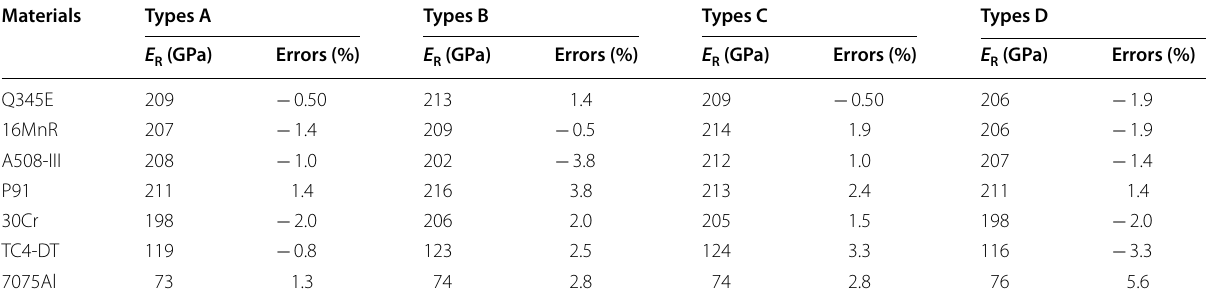
Table 5 Comparison between the predicted elastic moduli and those obtained by traditional tensile tests Materials Types A Types B Types C Types